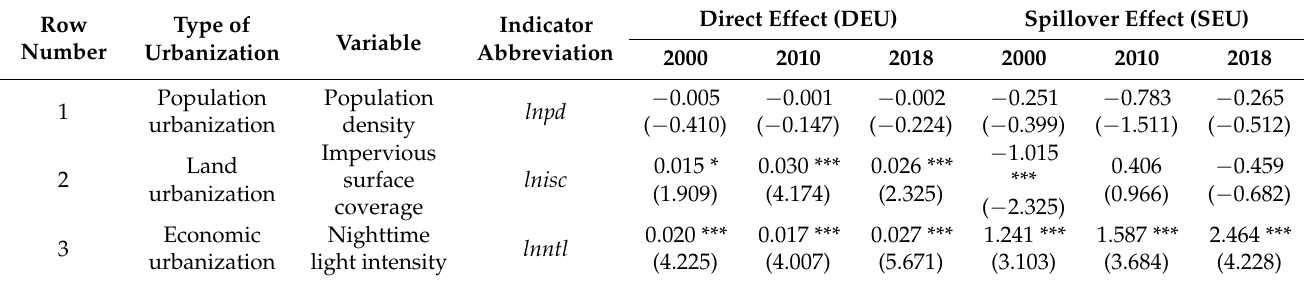
Table 5. Impact of multi-dimensional urbanization on PM 2.5 concentrations in 2000, 2010, and